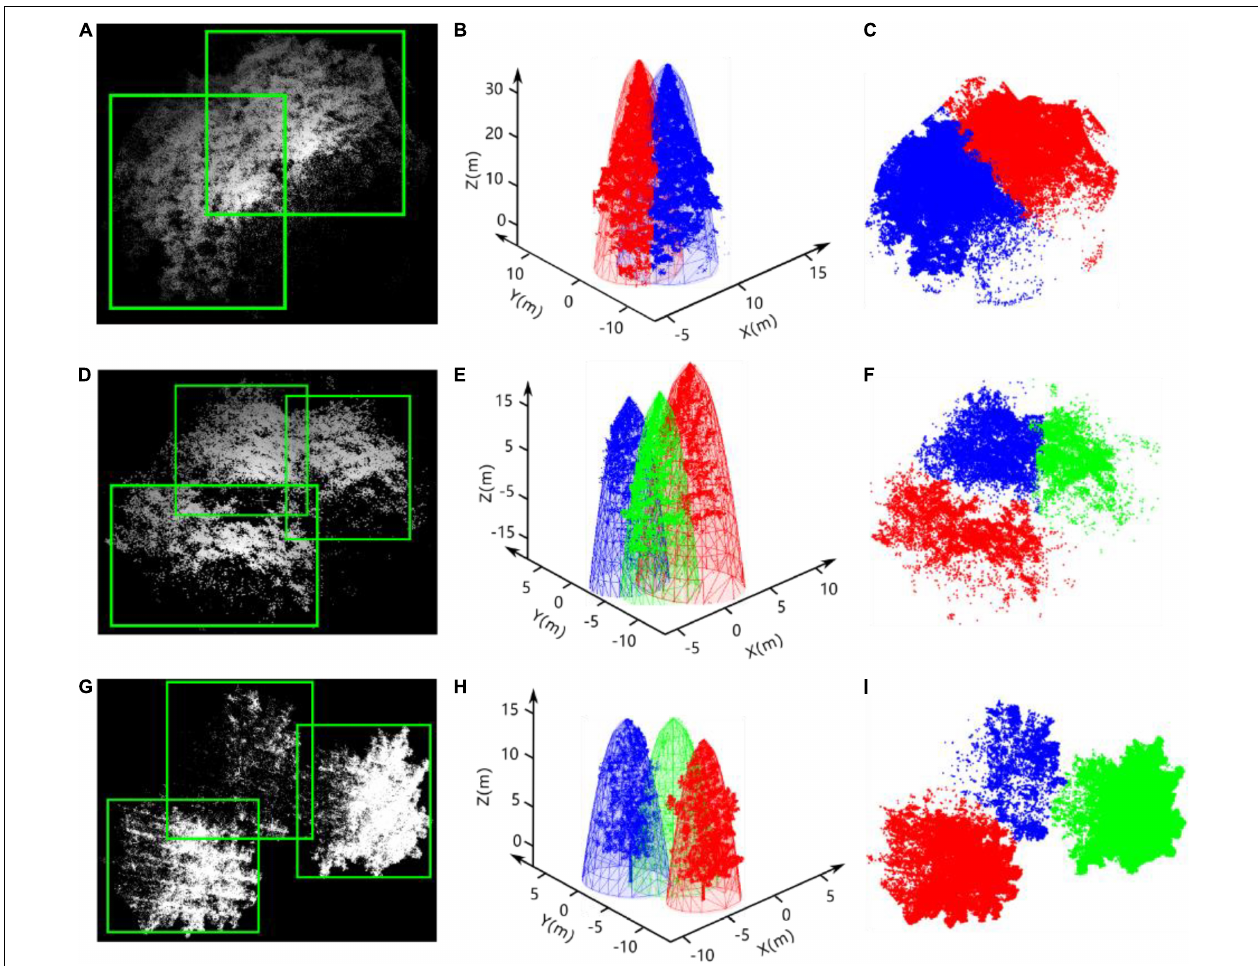
FIGURE 9 | Results of tree detection by improved YOLO-v4, the elliptic paraboloid fitting of tree crowns, and the segmentation of overlapping trees. As shown in (A,D,G) , the white points and green rectangular boxes represent the point cloud of adjacent trees and the bounding boxes, respectively. The paraboloid fitting results of each adjacent tree crown and the point cloud of each tree are shown in (B,E,H) . (C,F,I) Are the results of the segmentation of points in the intersecting area based on our method.